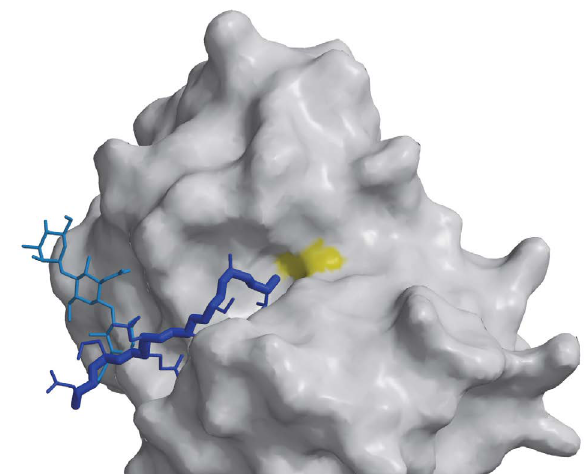
Figure 3. Cathepsin H 11 (8PCH). Cathepsin H is shown as white surface with catalytic Cys area in yellow. Mini chain and carbohy- drate rings responsible for its stabilization are shown as sticks in dark and bright blue,